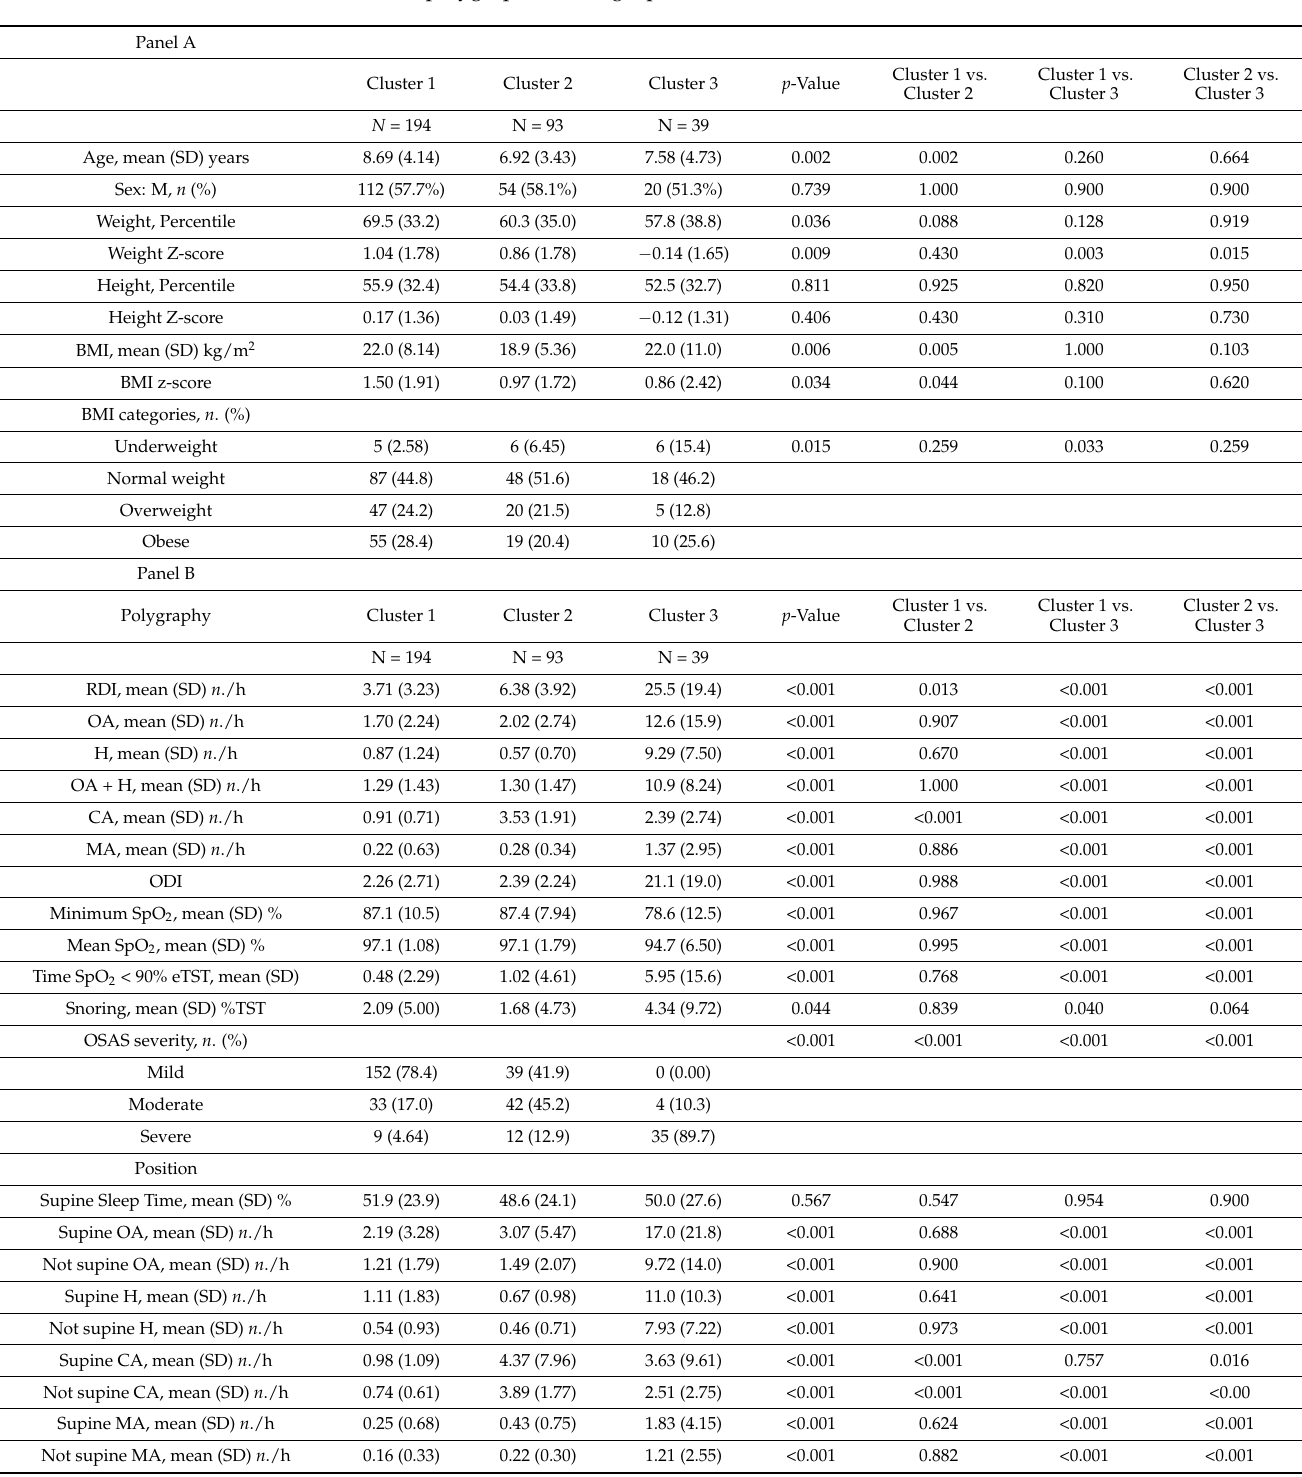
Table 2. Results of clusters characterization (n. 3) regarding the anthropometric parameters (panel A) and home polygraphic findings (panel